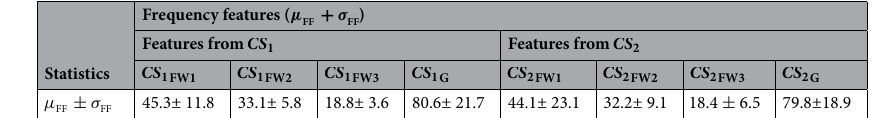
Table 2. Mean ( µ FF ) and standard deviation ( σ FF ) of the features.